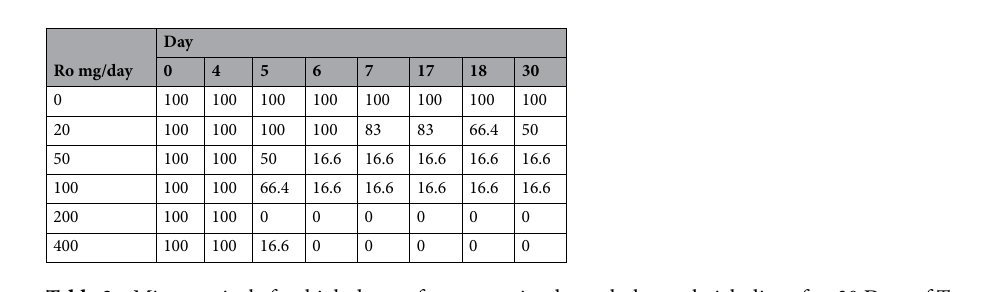
Table 3. Mice survival after high doses of rosuvastatin plus a cholesterol-rich diet, after 30 Days of Treatment. Ro rosuvastatin,